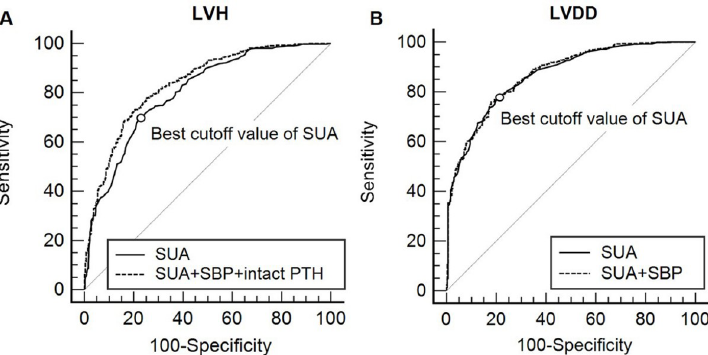
Fig 2. Receiver-operating characteristic curves of SUA levels for predicting the presence of LVH (A) and LVDD (B) in patients with pre-dialysis CKD (n = 1025). (A) The AUC for SUA levels was 0.803 (95% CI: 0.777–0.827) for LVH. The best cutoff value of SUA levels for predicting the presence of LVH was � 7.5 mg/dL with the associated sensitivity of 71.8% (95% CI: 67.2–76.0%) and specificity of 75.2% (95% CI: 71.5–78.6%). Notably, combination of SUA, SBP, and intact PTH exhibited AUC of 0.836 (95% CI: 0.812–0.860), which was significantly higher than that of SUA alone (0.836 vs. 0.803, P < 0.001). (B) The AUC for SUA levels was 0.867 (95% CI: 0.845–0.887) for LVDD. The best